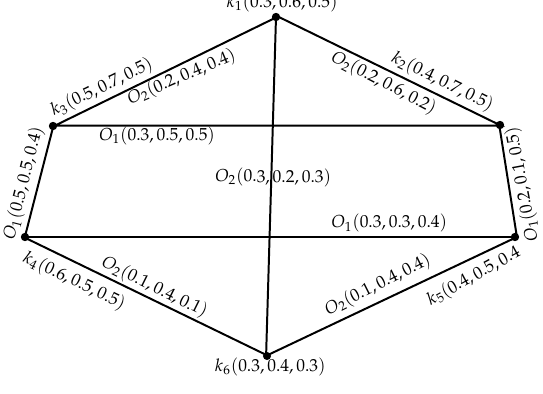
Figure 8. An IN fuzzy O 1